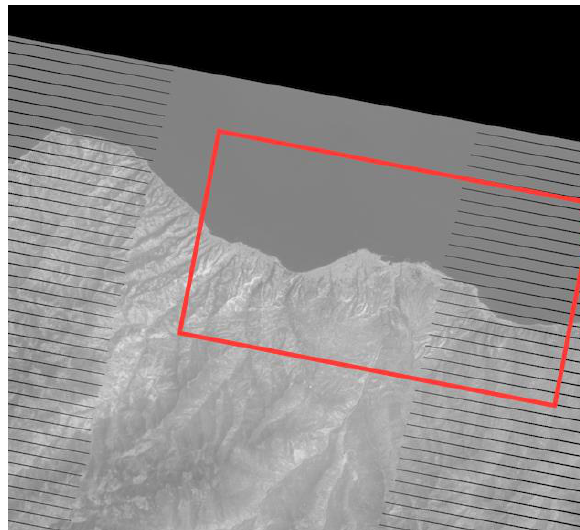
Figure 2. Missing lines in the satellite image of the region of interest Landsat 7 has eight bands: blue, green, red, near-infrared 1, near-infrared 2, thermal, mid-infrared, panchromatic. All of the bands have 30 meters resolution, except thermal with 60 and Table 1. Confusion matrix for images of years 2006 and 2009, panchromatic with 15 meters of resolution (GIS Geography, listing their true/false (T/F) positive/negative (P/N) detected 2017, USGS, 2017). Picked bands of the imagery are band 2, pixel numbers, overall accuracy, precision and recall in band 3 and band 4, representing, green, red and near infrared detecting vegetation, and two fScore combining precision and bands. These bands are selected since they are used in the recall values for each calculation of the NDVI. NDVI calculation is shown in equation